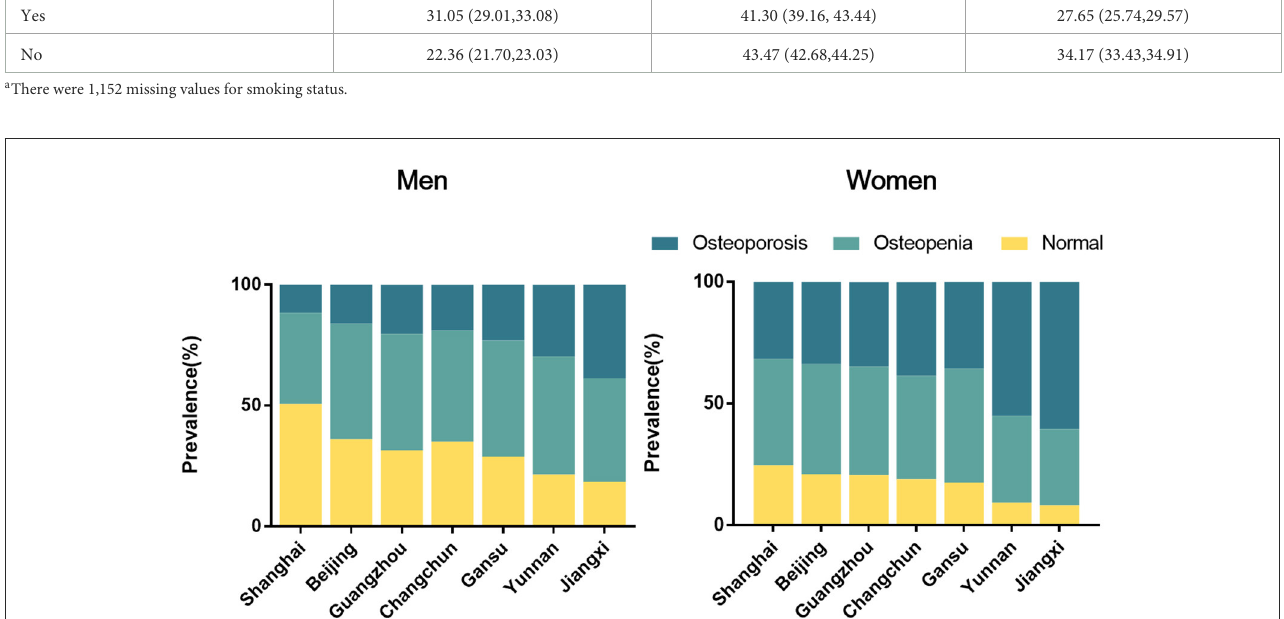
FIGURE2 Prevalence of osteopenia and osteoporosis in the middle-aged and elderly people in different regions of China by